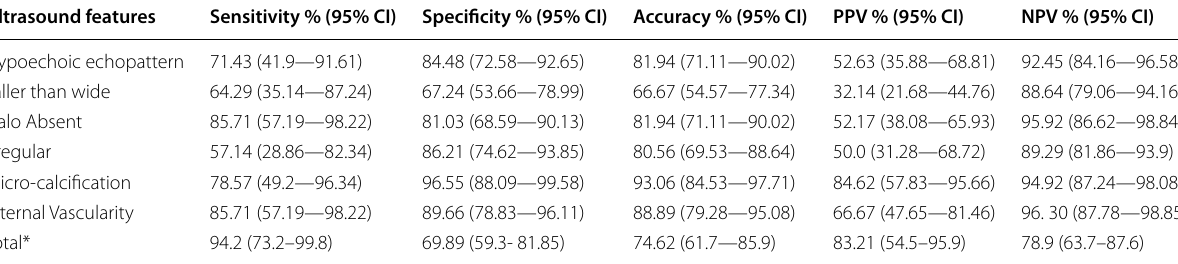
PPV , positive predictive value; NPV (negative predictive value *Total include all above